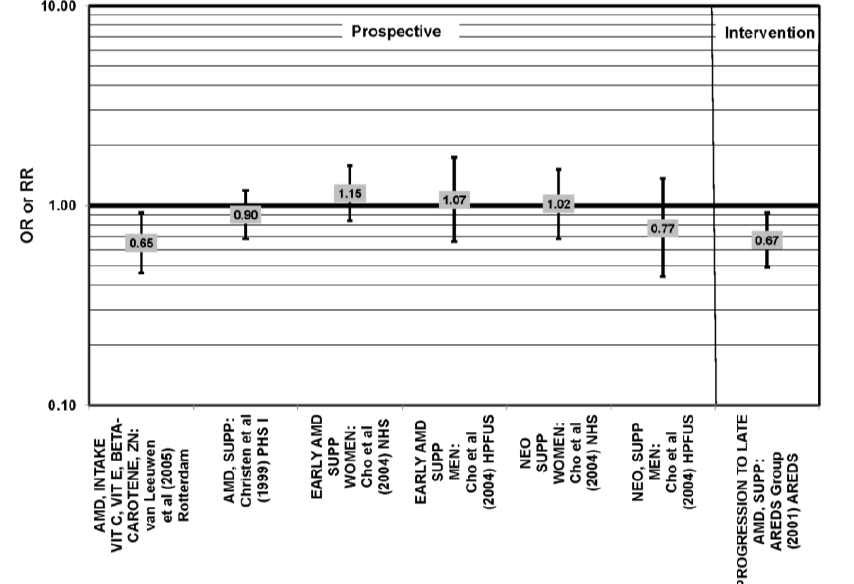
Figure 37. Odds or risk ratio for AMD, early AMD or neovascular (NEO) AMD; high vs. low intake of antioxidant combination or use of multivitamin supplement: prospective studies,